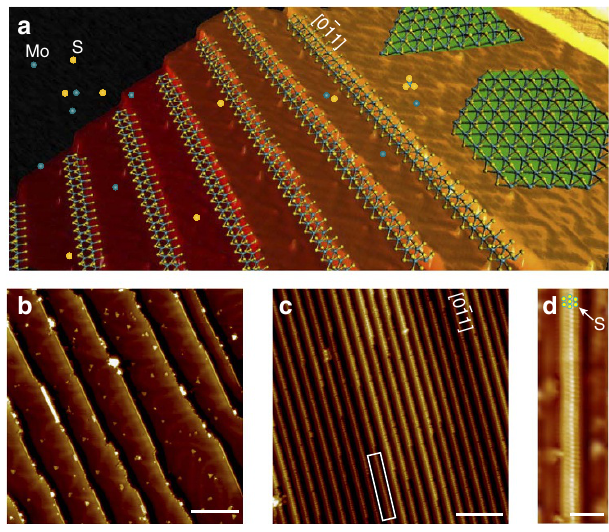
Figure 1 | Bottom-up synthesis of MoS 2 nanowire array on the vicinal Au surface. ( a ) Schematic illustration of the step-templated growth of MoS 2 nanowires on the Au(755) surface. ( b ) Large-area STM image of MoS 2 triangular nanoclusters and MoS 2 nanowires grown on an Au(111) surface. ( c ) Large-area STM image of MoS 2 nanowires aligned along the steps on the Au(755) surface. ( d ) Magnified view of the rectangle-enclosed region in c shows the atomic-resolved lattice of a single MoS 2 nanowire (S atom positions are indicated by yellow circles). Scale bars, 10nm in ( b , c ) and 1nm ( d